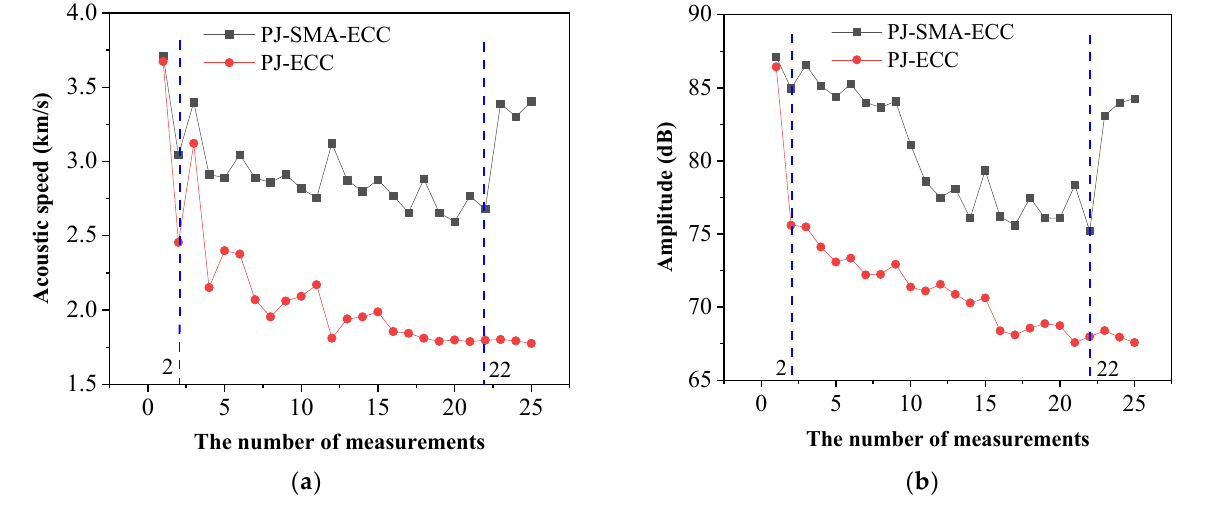
Figure 17. The variation in the acoustic speed and amplitude of specimens PJ-SMA-ECC and PJ-ECC. ( a ) The variation in acoustic speed; ( b ) The variation in amplitude.